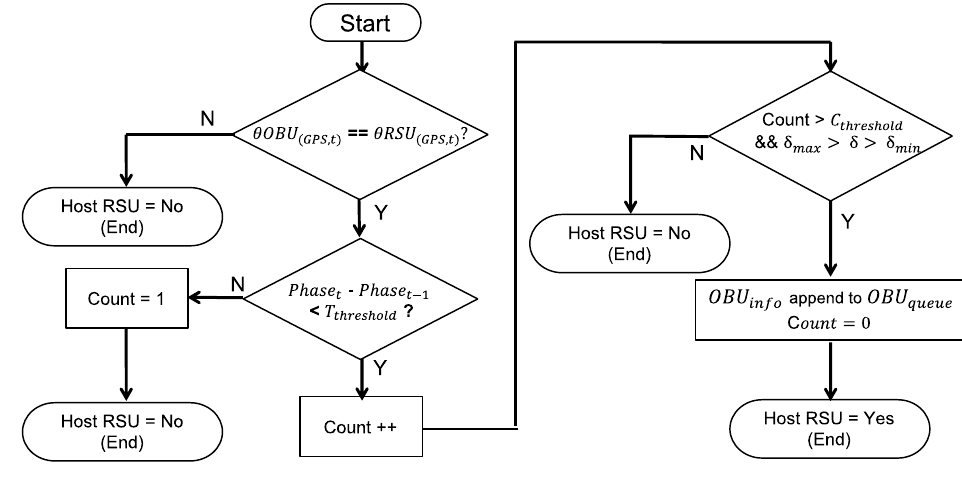
Figure 8. HostRSU algorithm.